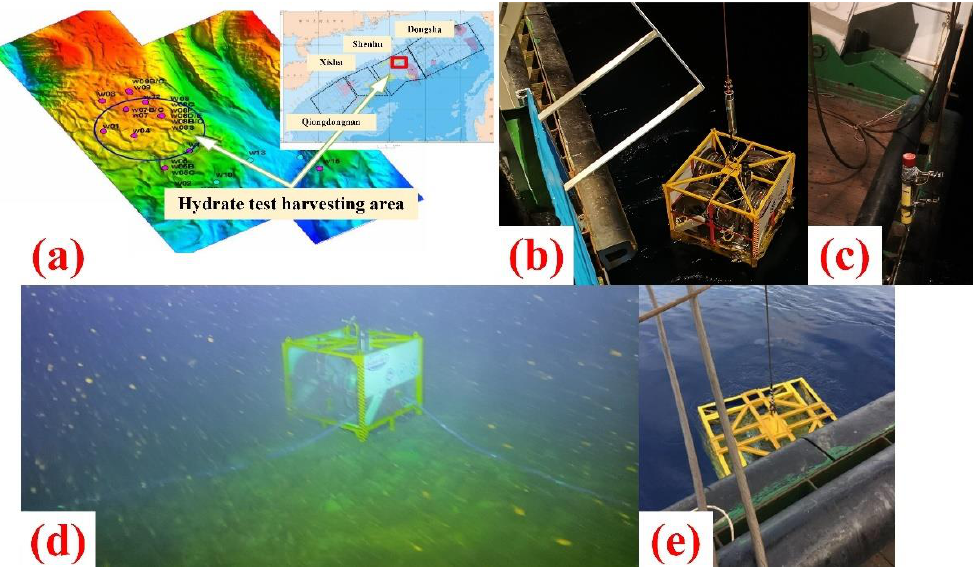
Figure 14. ( a ) “Shenhu” test harvesting area; ( b ) Device devolving; ( c ) Beacon ( d ) Sensor cables deployment; ( e ) Device recovering.